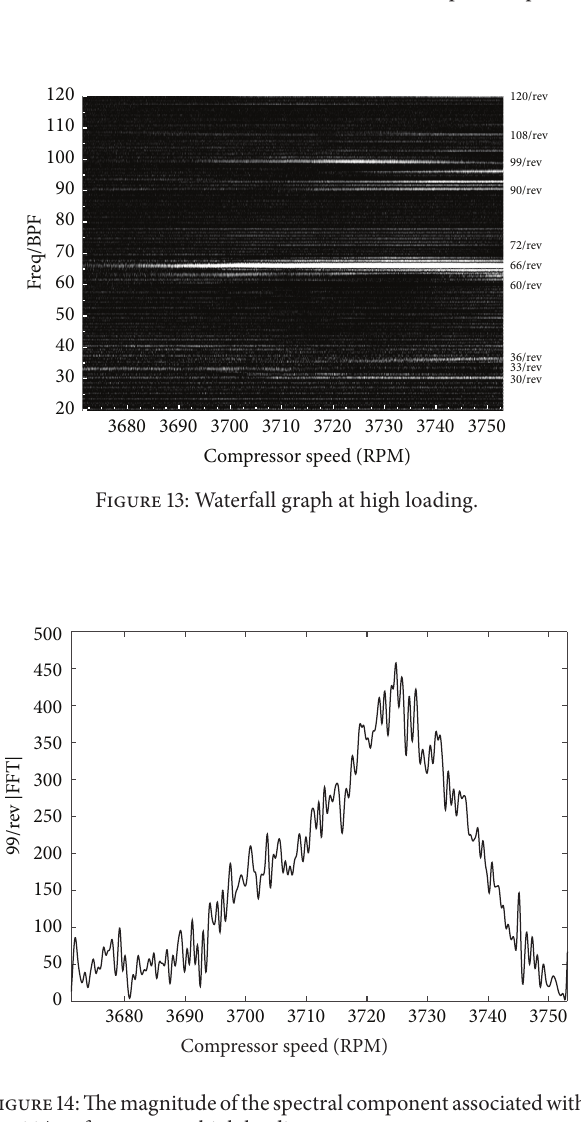
Figure 12: NL (a) and HL (b) peak-to-peak deflection of each blade of R2 as recorded by NSMS.